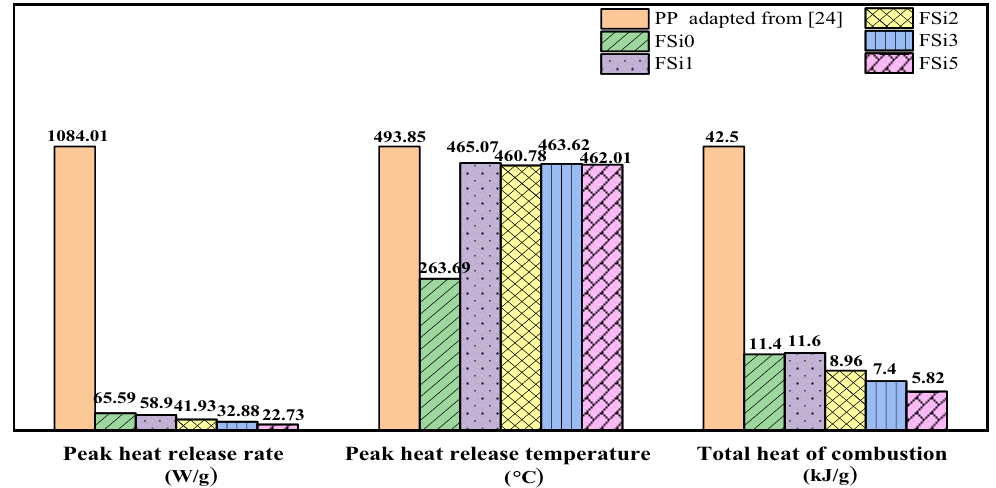
Figure 9. The peak heat release rate, peak heat release temperature and total heat of combustion of fungal fibers grown with different contents of Si source as well as PP